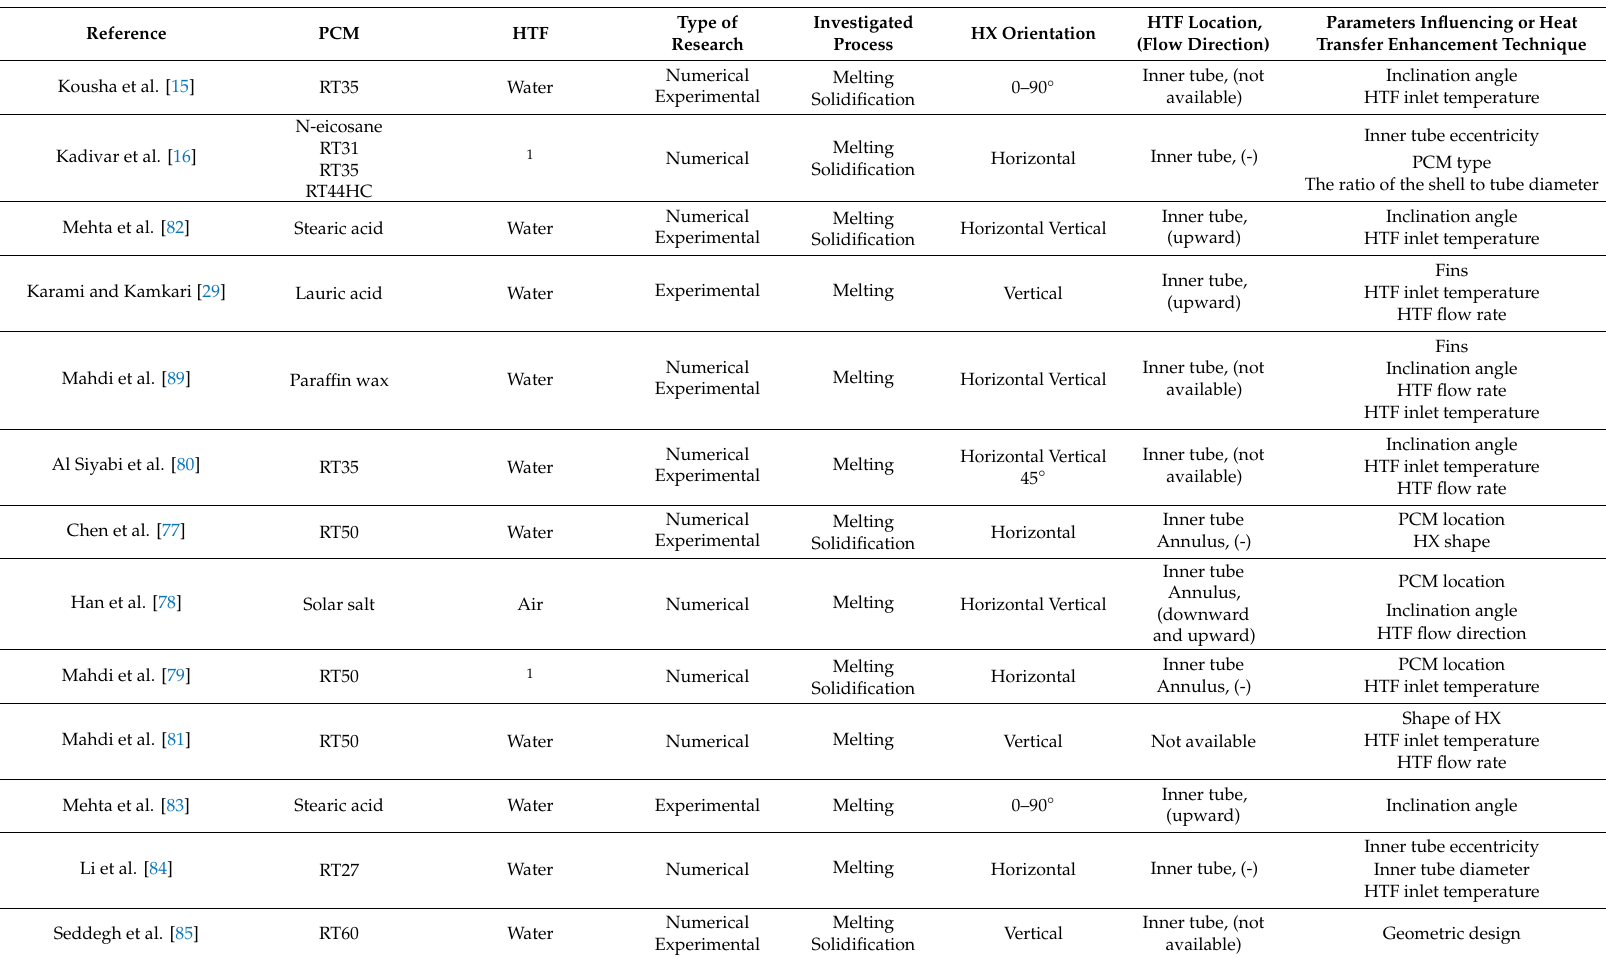
Table 4. Research on the double-tube heat